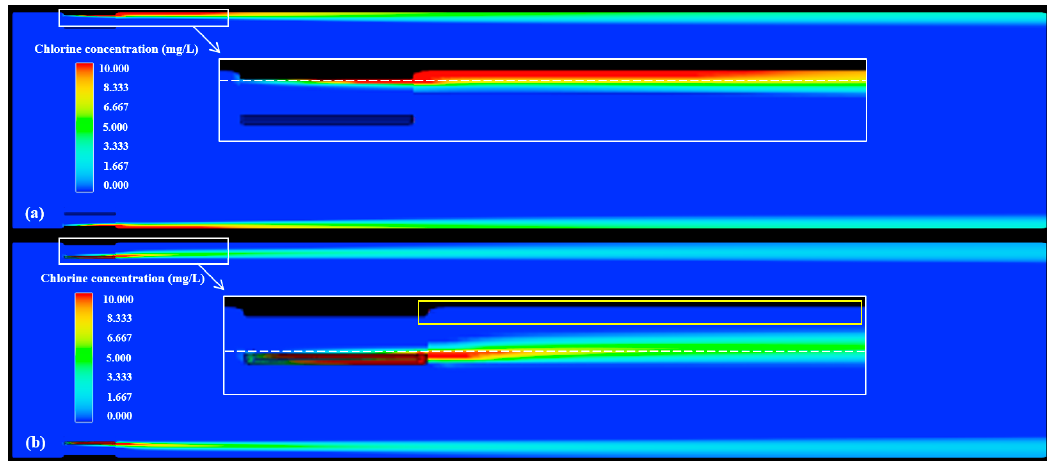
Figure 8. Chlorine concentration contour in the simulation of full-scale in-situ electro-chlorination with different cathode positions. The pipe diameter is 2 m and the flow rate is 14 m 3 s − 1 . The figure shows 10 m of the pipeline. ( a ) The simulation result when the cathode is placed on the surface of the pipe wall. ( b ) The simulation result when the cathode is placed on the inside of the pipe with 100 mm of distance from the pipe wall.